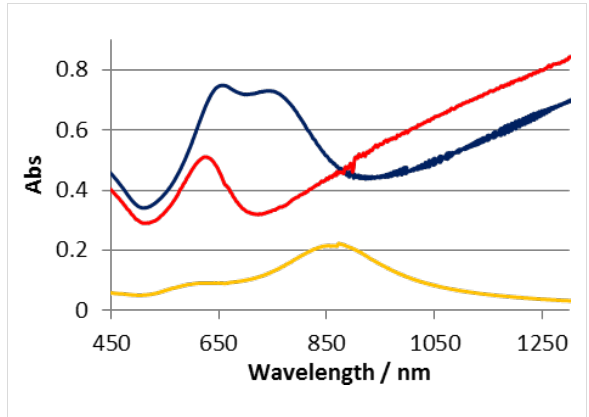
Figure 2: Extinction spectra of arrays of cap (yellow), hole (red) and cap/hole (blue) structures with 110 nm diameter in 20 nm gold on glass